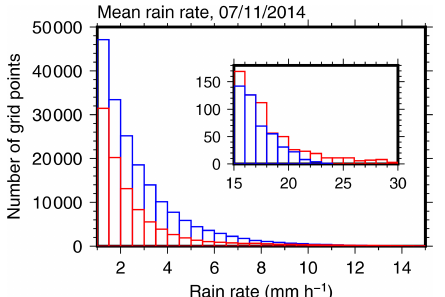
Figure 8. Time series of the median differences between the SST in the CPL and NOCPL simulations, in the whole domain (red) and in the EF600 area (blue; see text for definition), on 7 November. The boxes indicate the 25% and 75% quantiles and the whiskers the 5% and 95% quantiles. The SST differences in the EF600 area between the NOCUR and NOCPL simulations are also shown (cyan). Some of the boxes have been slightly shifted horizontally for